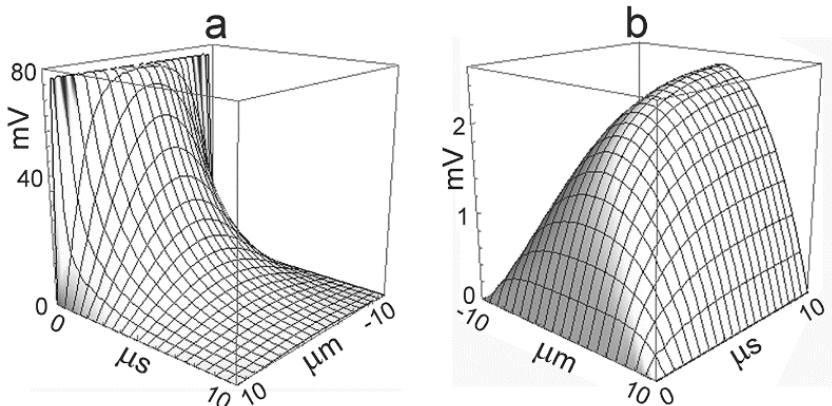
Figure 2. Time-dependent profiles of the extracellular voltage V J (a,t) in a circular cell-substrate junction upon intracellular stimulation by a voltage step of 100 mV: ( a ) response to capacitive current; and ( b ) response to ionic current. The dynamics in the microsecond range is determined by the time constant of the lowest mode of the core–coat conductor. For the parameters, see text. Note the different orientation and different voltage scales of the diagrams.